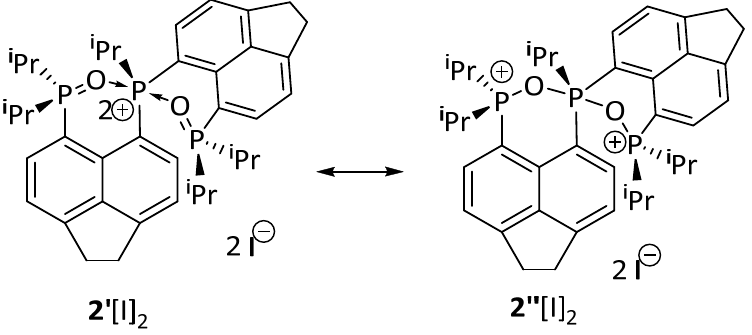
Figure 2. Bonding models for 2 [I] 2 .